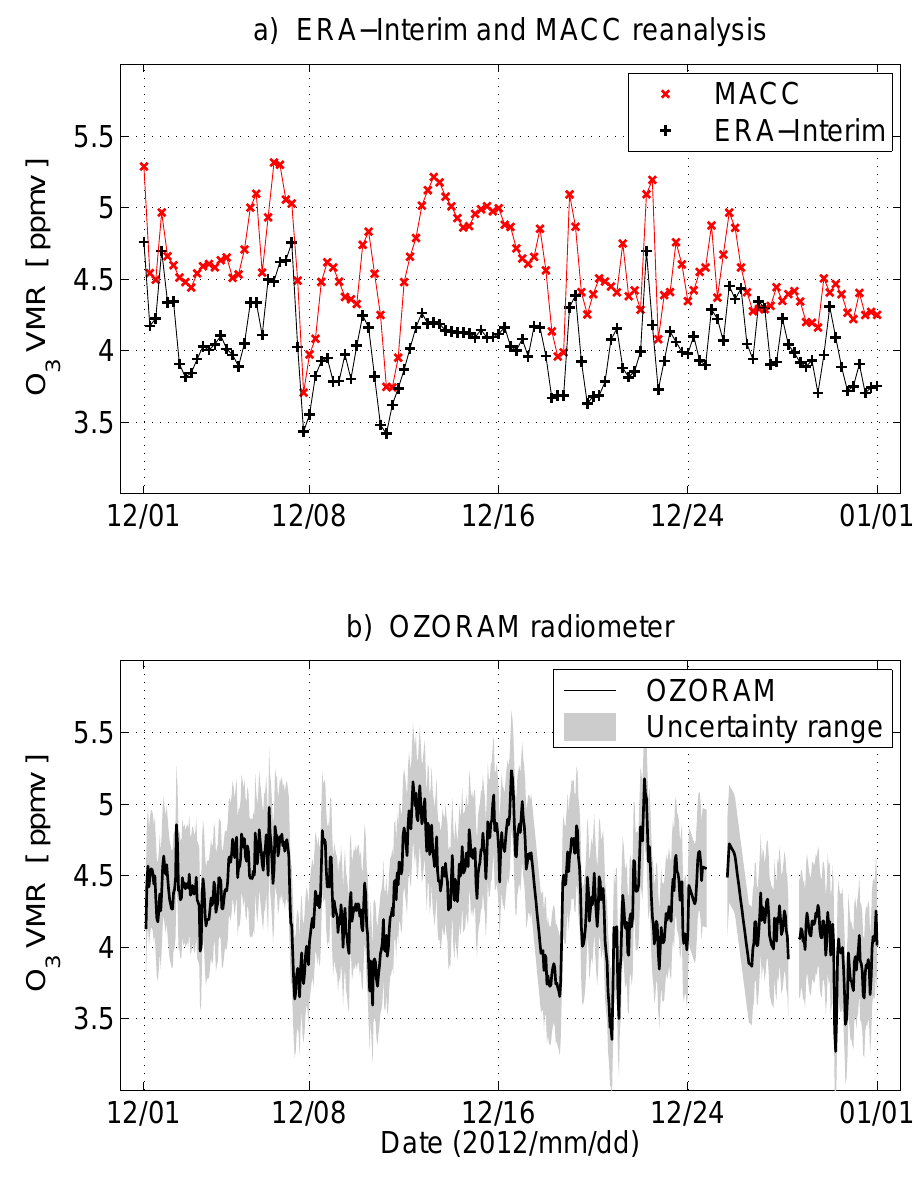
Figure 8. Similar to Figure 7 but for December 2012. The label 01/01 corresponds to 2013/01/01. In the southern hemisphere, MACC reanalysis and ERA-Interim indicate a diurnal vari- ation during Antarctic winter of approximately 8% at the polar circle (see Figures 2b and 4b). During the polar night, photochemical variations are negligible so that dynamics are con- sidered as the origin of this diurnal variation in ozone. A view on the diurnal ozone variation with focus on the Arctic and Antarctic is presented in Figure 9 for the three model systems. The figure presents the peak-to-valley difference corresponding to Equation (7) on the northern and southern hemisphere for June 2012. Thus, the upper panels describe Arctic summer (polar day) and the lower panels Antarctic winter (polar night) situations, respectively. In the northern hemisphere the magenta markers indicate the geographical location of OZORAM at Ny-Ålesund, Svalbard. Figure 9a,b displays the strong diurnal variation in the Arctic summer which was locally confirmed by OZORAM (see marker for Ny-Ålesund). Compared to WACCM and MACC, ERA-Interim shows too little diurnal variation in this region (Figure 9c). In Figure 9e,f, the reanalysis systems MACC and ERA-Interim consistently show an enhanced diurnal ozone variation in the polar